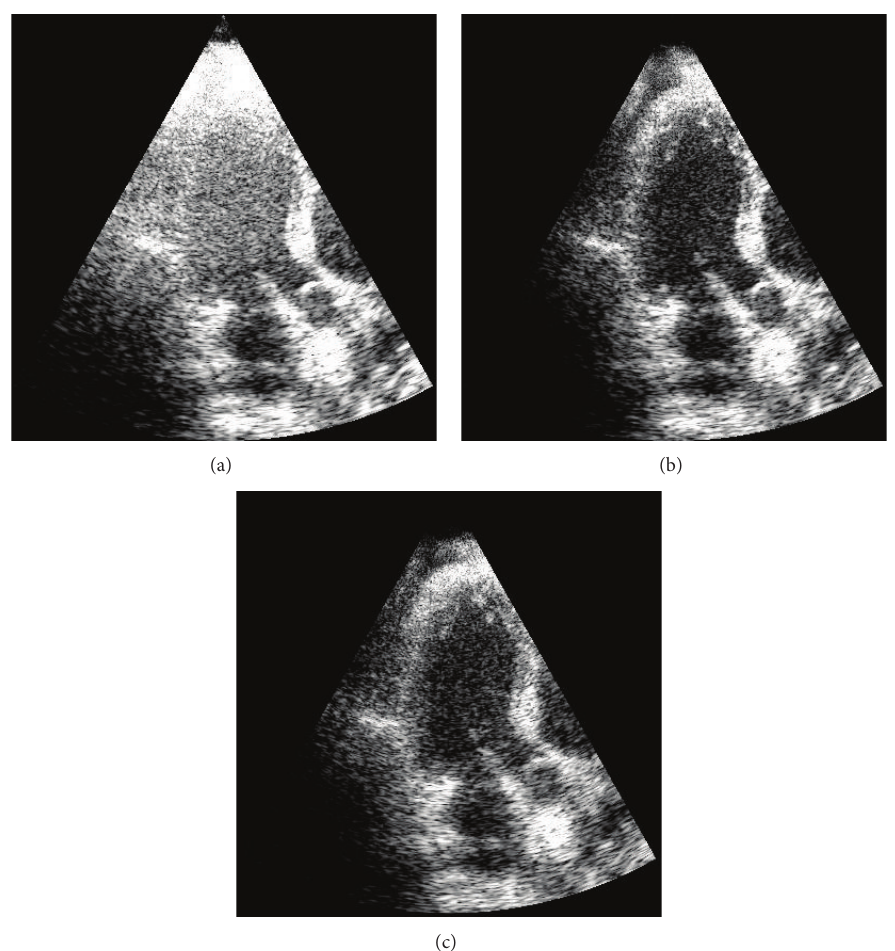
Figure 14: A heavily cluttered apical view of heart images illustrated before filtering (a) and after clutter removal with MCA (b) and after applying SVF (c). Images are shown on a log compressed linear gray scale mapping to 0 to 30